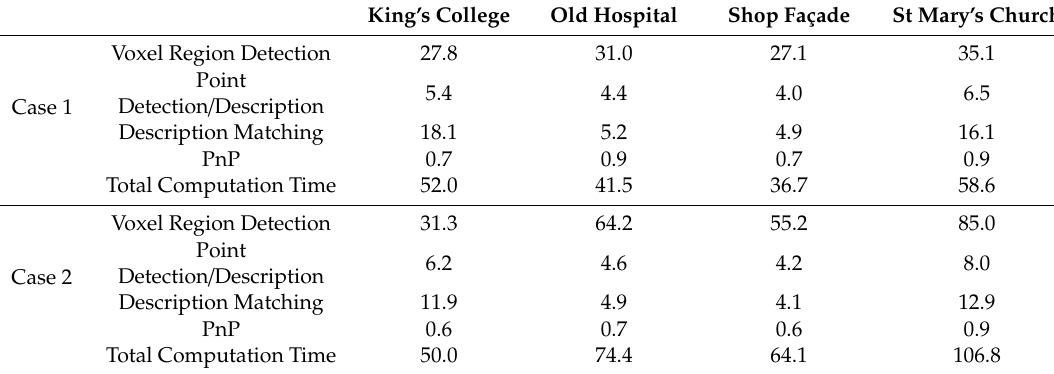
Table 4. Comparison of computation time (ms) required for individual procedures in camera pose